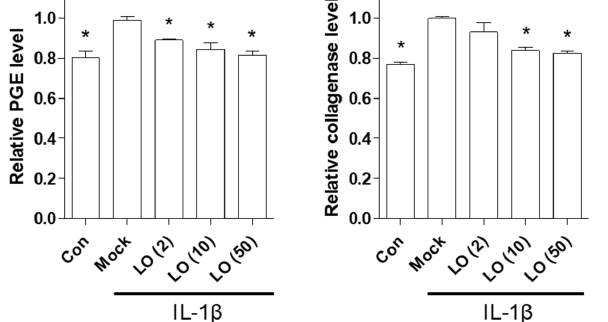
Figure 4. Loganin prevents IL-1 β -induced PGE 2 and collagenase production in mouse chondrocytes. Mouse primary chondrocytes were treated with IL-1 β (1 ng/mL) and loganin (2, 10, and 50 µ M)